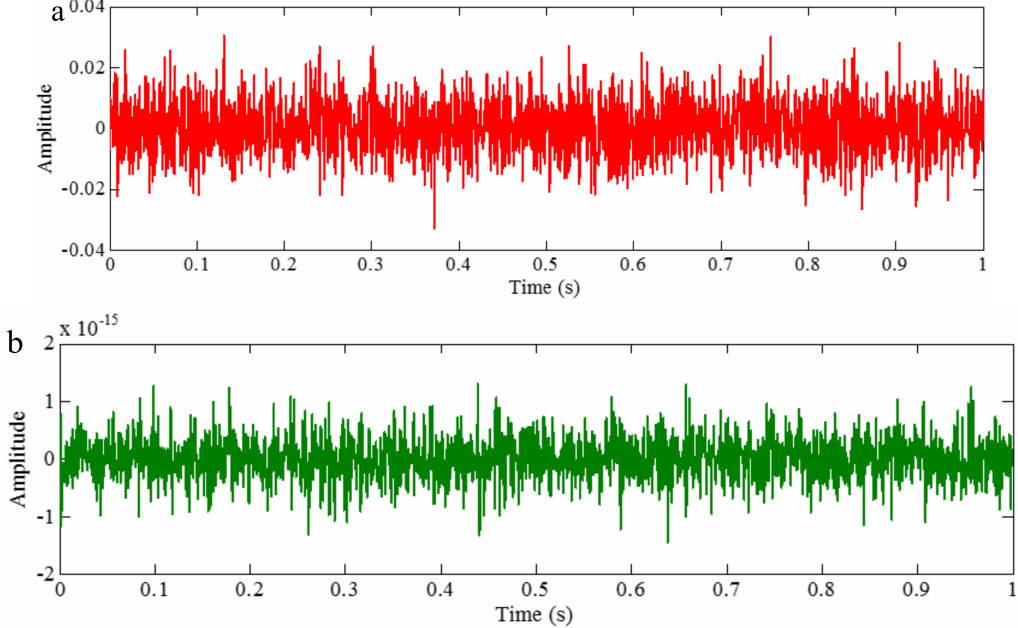
Figure 18. Residues of added white noises derived by EEMD and CEEMD: ( a ) EEMD and ( b )